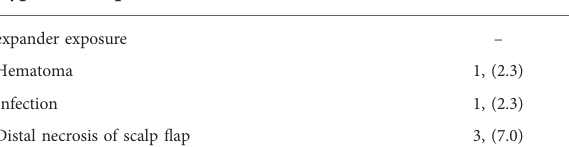
TABLE 3 Complications.